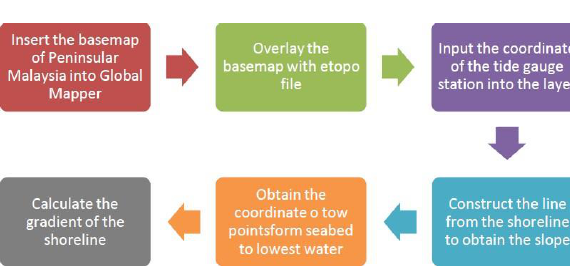
Figure 6. Data Processing for Global Mapper.